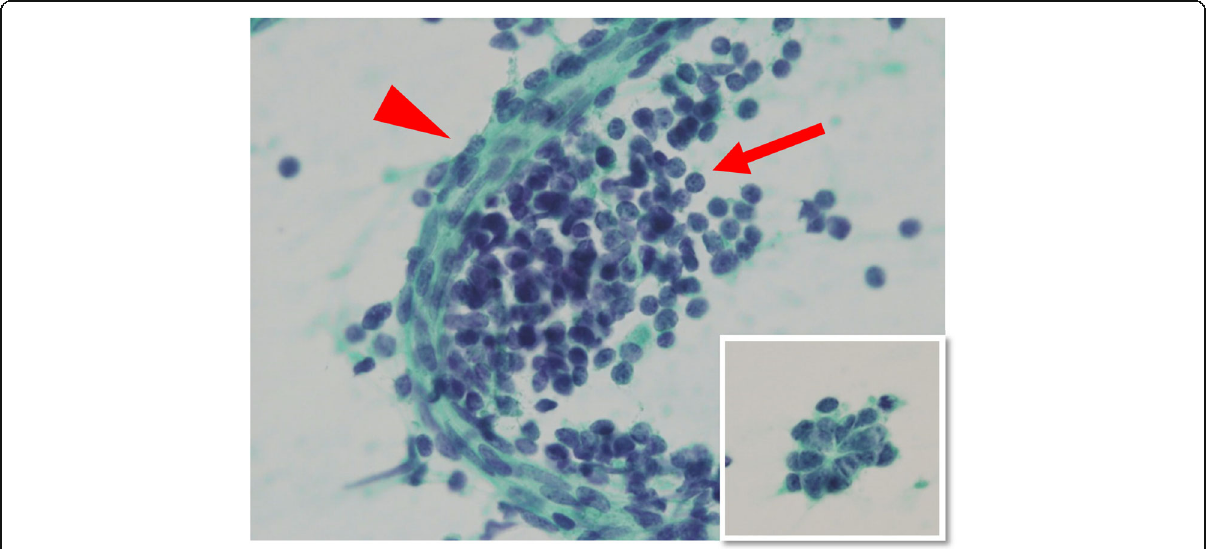
Fig. 2 Cytology of the peritoneal fluid. Three components of blastemal, stromal and epithelial cells were seen. The blastemal cells showed decreased cell adhesion (arrow), the stromal cells showed a fibroblast-like configuration (arrow head), and the epithelial cells showed a tubular structure (inset) (Papanicolaou staining, ×400)